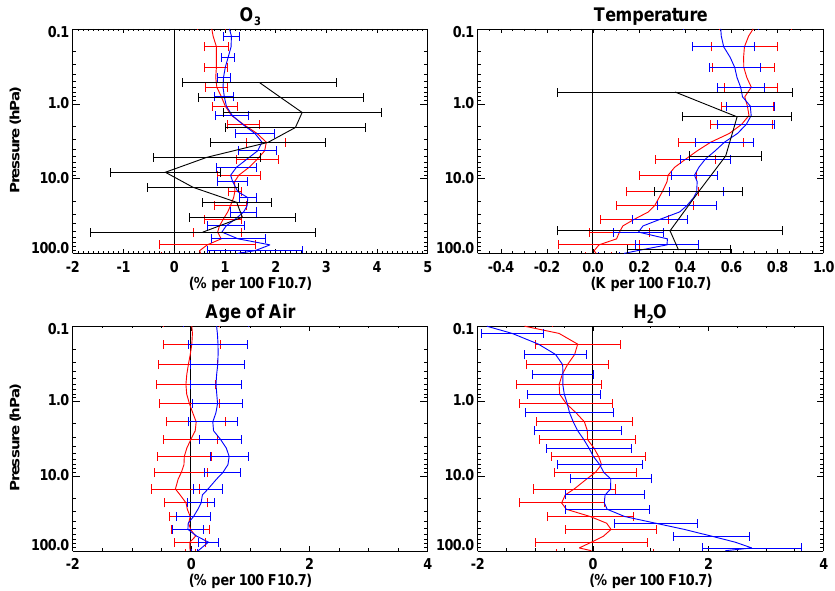
Fig. 24. Tropical average over 25 ◦ S–25 ◦ N of ozone, temperature, age of air and water vapour regression fits to the F10.7 index for the ensemble without EPP (red) and the ensemble with EPP (blue). Regression fits for observed ozone (SAGE corrected SBUV, McLinden et al., 2009) and SSU/MSU temperature (Randel et al., 2009) are also shown (black). Horizontal axis values are % per 100 units of F10.7 except for temperature which is in K. Error bars are ± 2 σ .